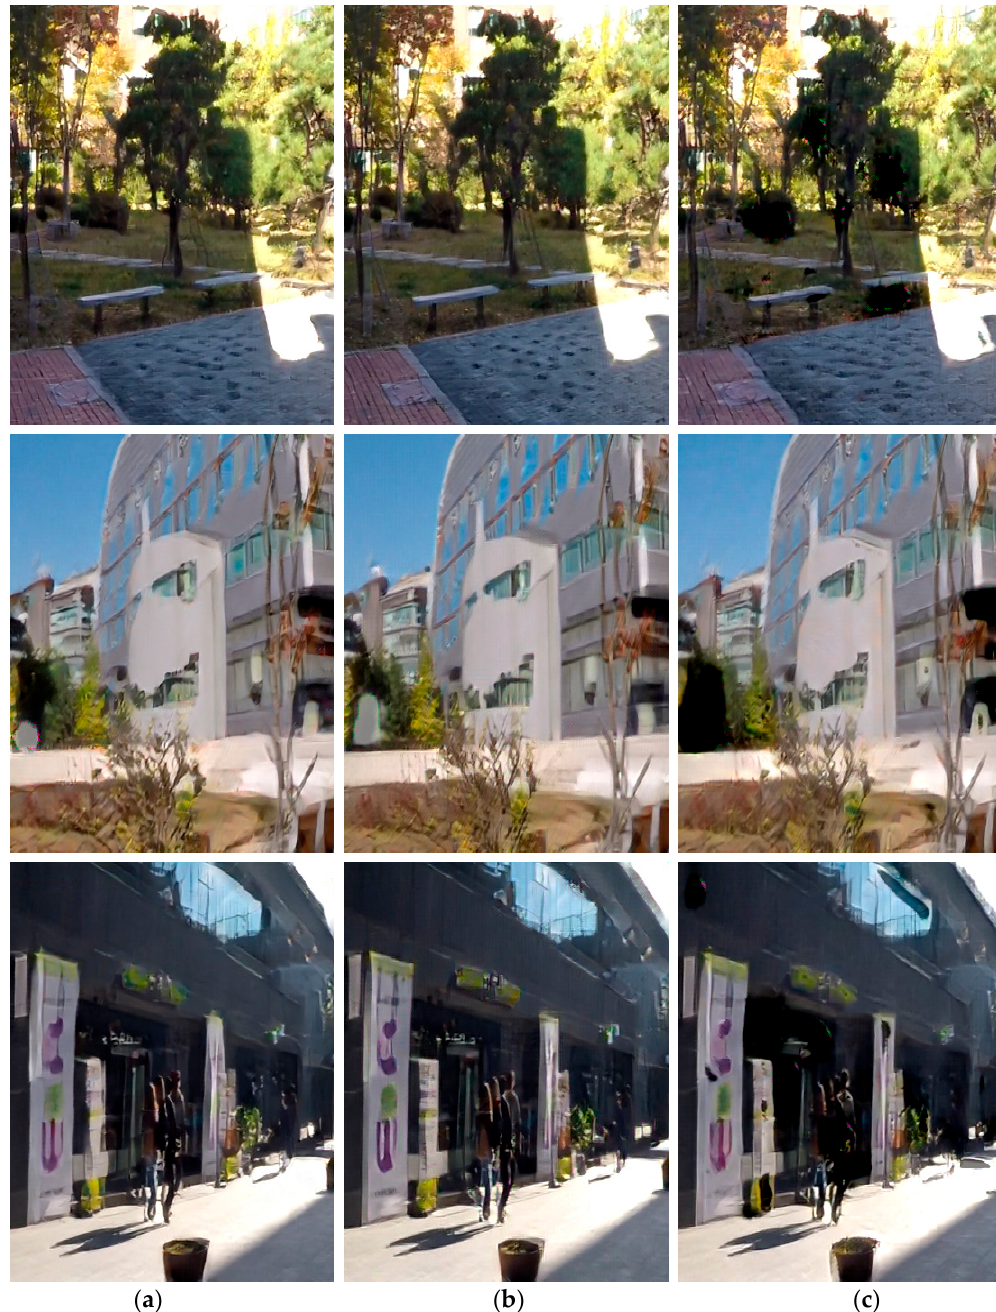
Figure 25. Generated background images according to different λ values: ( a ) λ =10 ( b ) λ =100 ( c ) λ =1000.